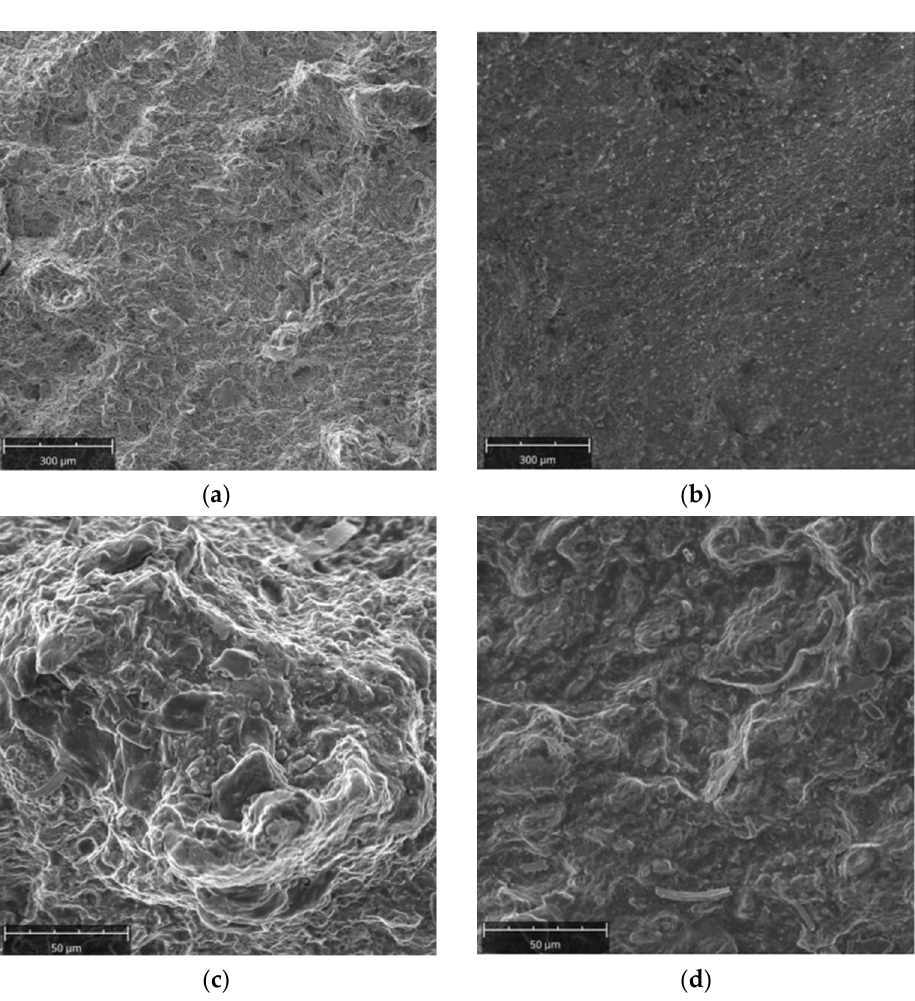
Figure 8. Oxidized fracture surface of the investigated die insert: ( a ) visible fatigue striations, ( b ) dominance of transcrystalline fracture, ( c , d ) intercrystalline fracture areas.